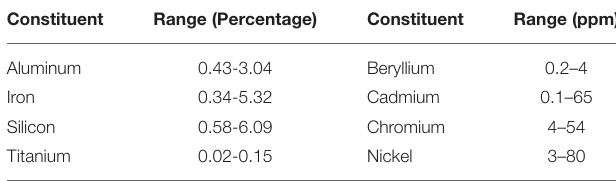
TABLE 2 | Elements and trace elements in coal.